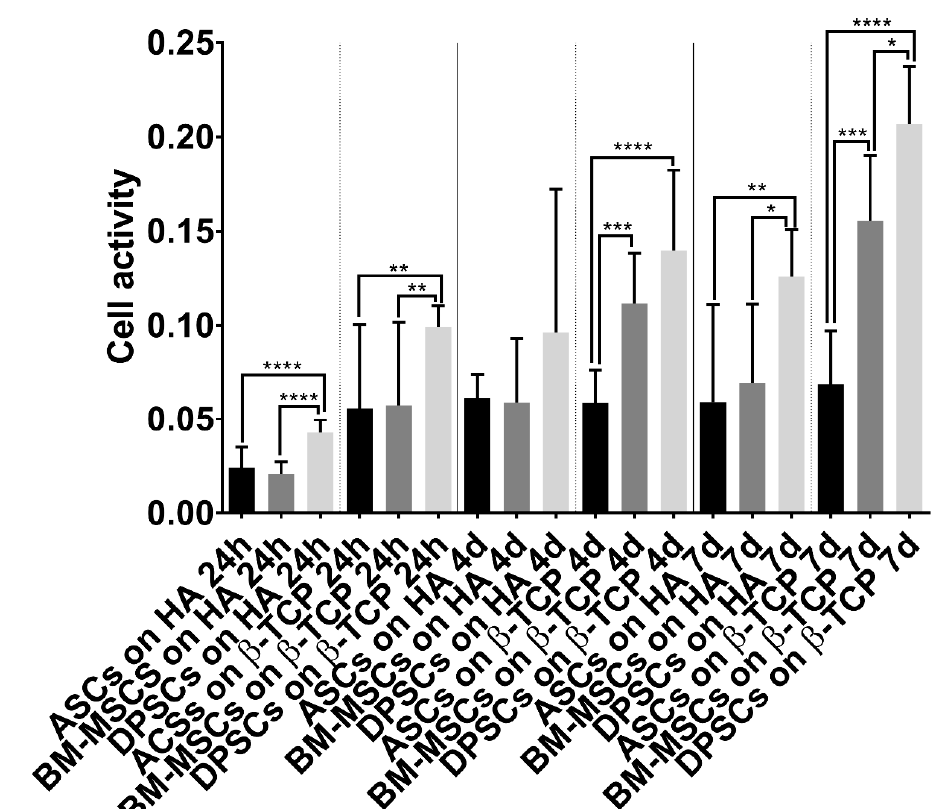
Figure A2. Cell activity during induced osteogenesis. Alamar Blue test results obtained by MSC–CaP combinations in osteogenic medium at the following time points: 24 h, 4 days, and 7 days. Data are shown as mean ± standard deviation. Significance level: * p ≤ 0.05, ** p ≤ 0.01, *** p ≤ 0.001, **** p ≤ 0.0001.